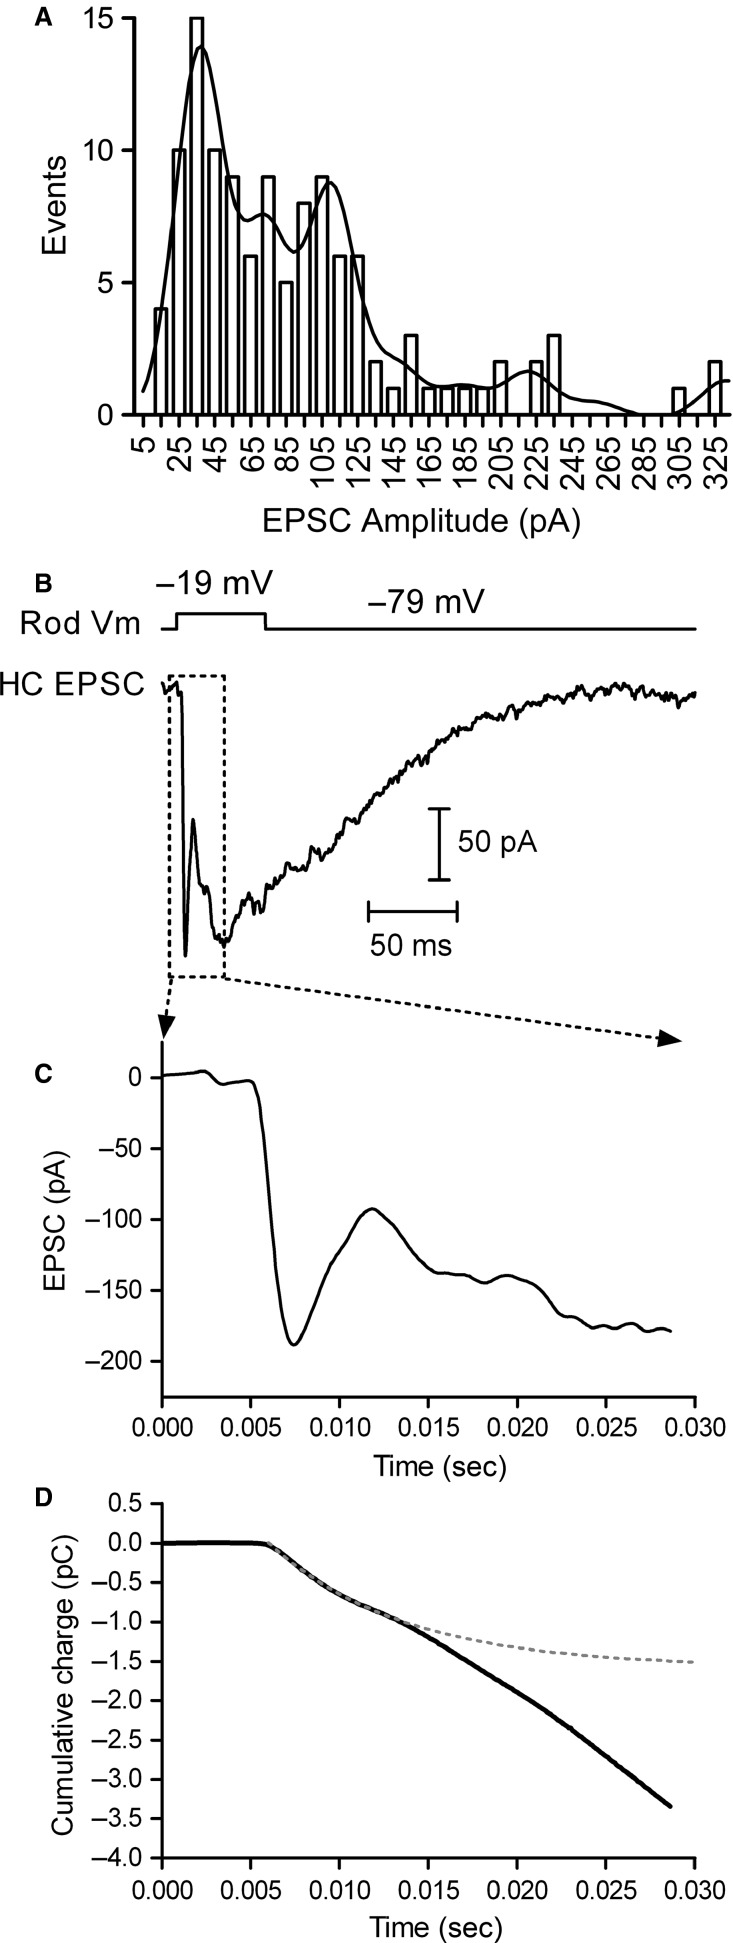
Immediately releasable pool (IRP) size in rods. (A) Distribution of rod-driven phasic EPSCs from 117 rod-HC pairs. The distribution was fit with a multiple Gaussian function with components of 35.9 pA, indicating that each ribbon contributes ˜36 pA to the rod-driven EPSC. The large peaks at 35.9, 71.8, and 107.7 pA indicate most rods make 1–3 ribbon contacts (average = 2.3) with each postsynaptic horizontal cell. (B–D) Analysis of the rod IRP from EPSC charge transfer measurements. (B) EPSC evoked by 50 msec depolarization to –19 mV in a rod-HC pair. The initial fast peak is the EPSC resulting from release of the IRP and had an amplitude of 188 pA, indicating that this rod made ˜5 ribbon contacts with the recorded horizontal cell. (C) Expanded view of the fast component of the EPSC. The expanded region is marked with the box in panel B. (D) Cumulative charge of the EPSC (black). The fast component, fit with a single exponential function (dotted gray), had a time constant of 7.5 msec and an amplitude of 1575 fC. Dividing by the number of ribbon contacts (5) and single vesicle charge (16 fC) gives a pool size of 19.7 vesicles/ribbon for this rod.